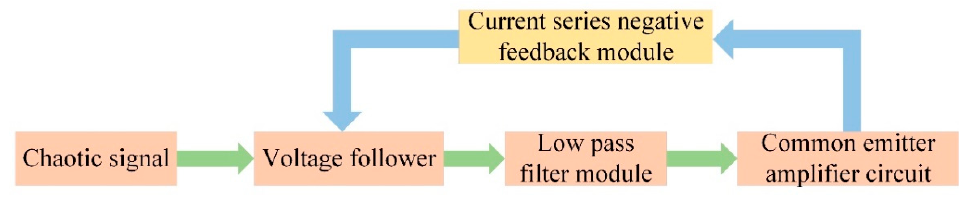
Figure 5. Amplifying matching circuit flow chart.